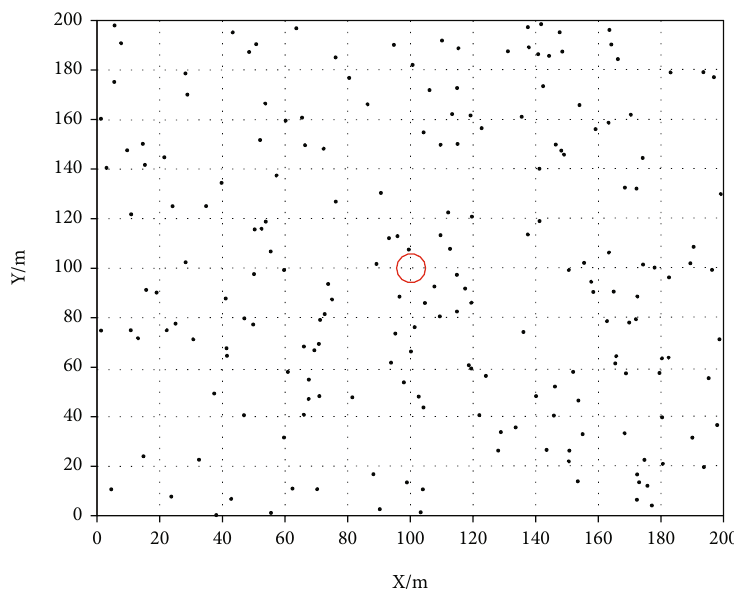
Figure 9: Distribution of 100 nodes in 200 × 200m 2